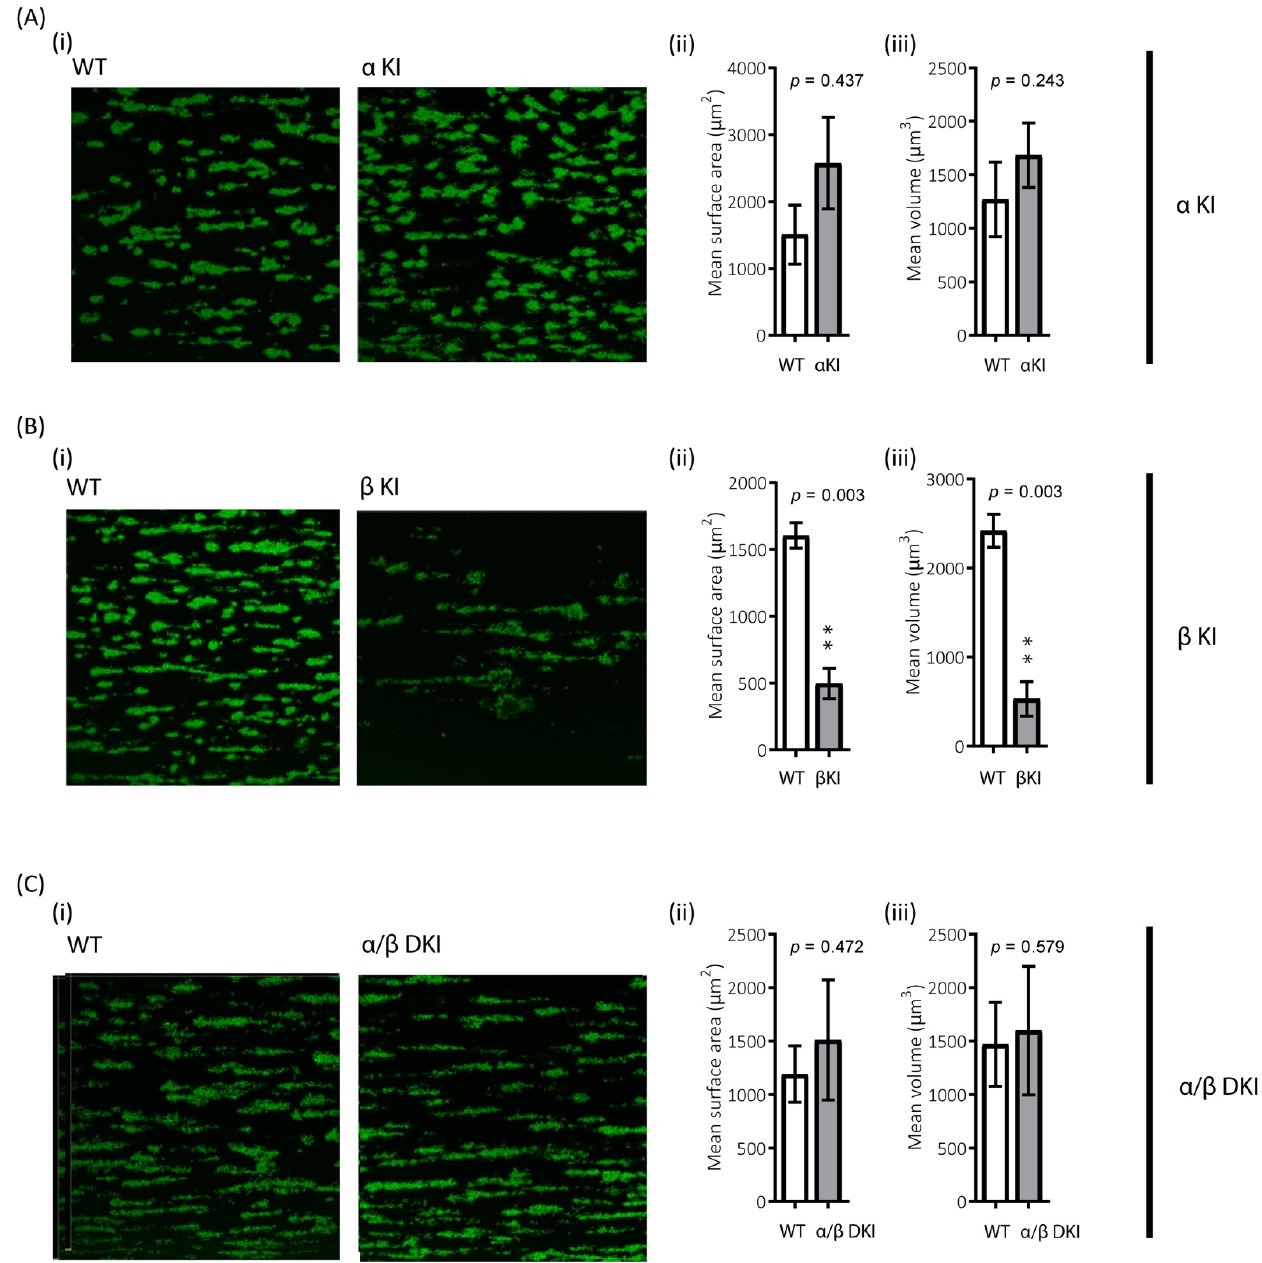
Figure 8. Reduced platelet accumulation on collagen under shear in blood from phosphorylation-resistant GSK3 β mice. Whole anticoagulated blood was flowed at 1000 s − 1 over fibrillar collagen coated Ibidi ® µ-slides (for parallel flow assays): ( A ) Blood from α KI mice exhibited similar amount of platelet deposition compared to WT controls ( n =12). In contrast ( B ) Blood from β KI mice exhibited reduced platelet deposition compared to WT controls ( n = 7). ( C ) Blood from α / β DKI mice exhibited similar amount of platelet deposition compared to WT controls ( n = 10). Thrombus formation was quantified from fixed samples (end-point) by imaging 5 randomly chosen fields of view using a Leica SP5-II confocal laser scanning microscope attached to a Leica DMI 6000 inverted epifluorescence microscope (Leica Microsystems, United Kingdom). Data are representative images, and quantification of surface area covered µm 2 and total thrombus volume µm 3 . Student’s t -test was used to test for statistical differences between genotypes **: p < 0.01.